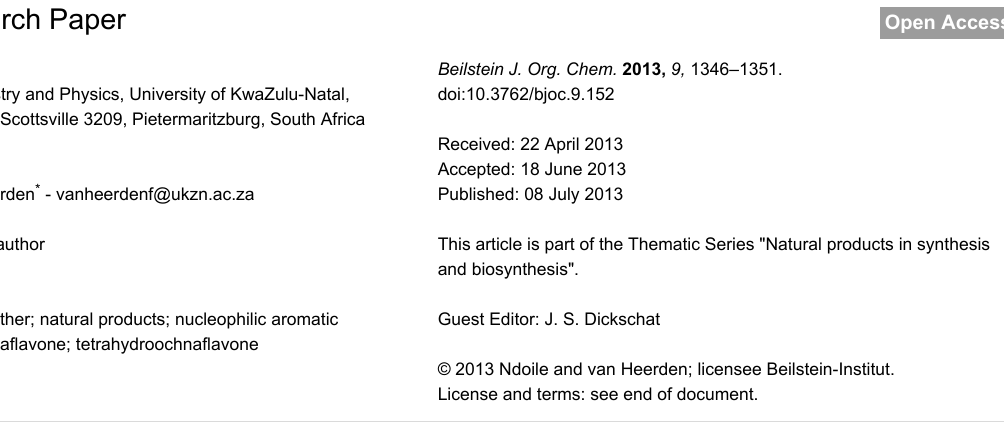
Ochnaflavone ( 1 ) (Figure 1) is a biflavone with an ether linkage between the B-rings of the apigenin and luteolin subunits [12], which has been isolated from several members of